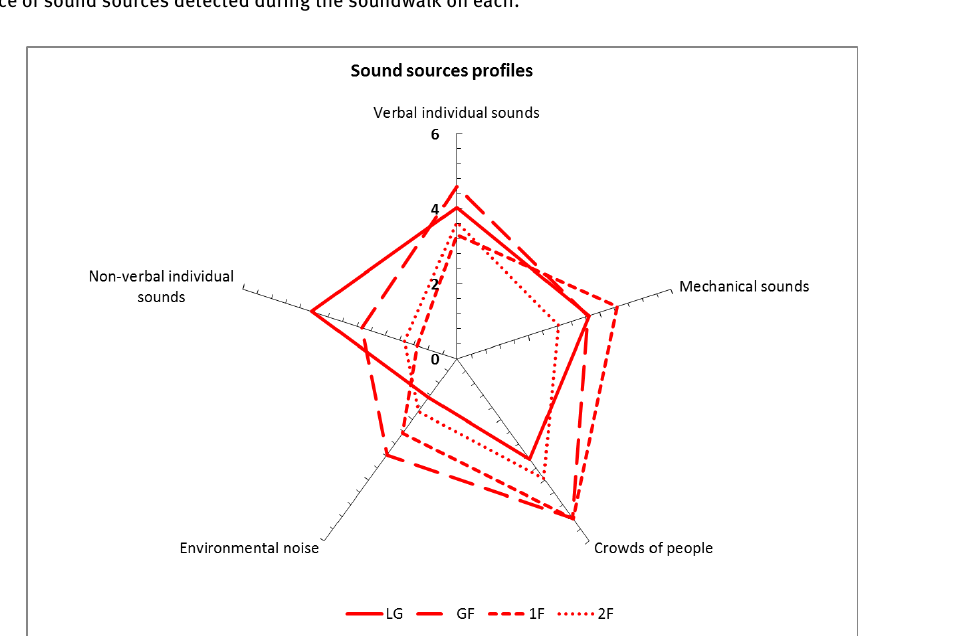
Figure 5: Aggregated Sound source profiles for each